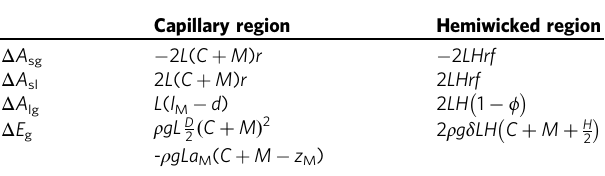
Table 2 The free energy change contributions to Δ G arising from the capillary and hemiwicked regions. Capillary